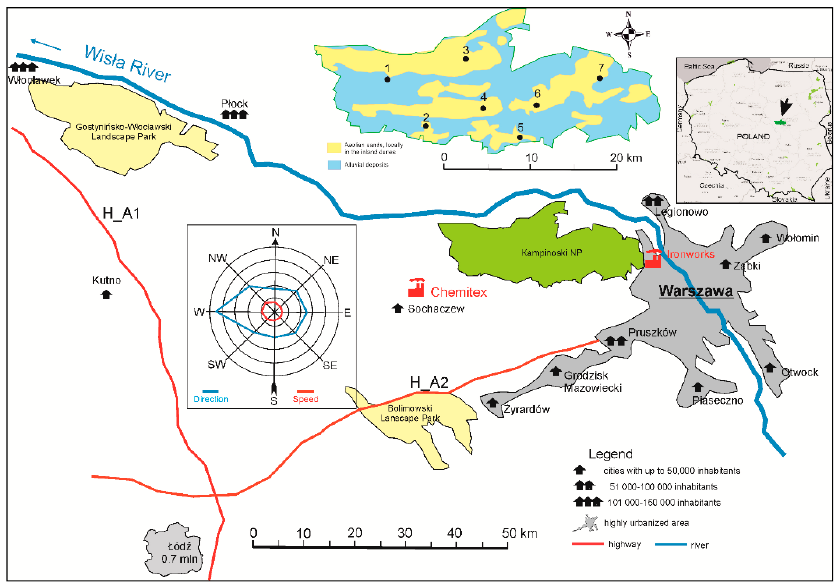
Figure 1. Location of Kampinoski National Park (KNP, area marked in green) in relation to the important spatial elements that may affect the park. In the upper right corner, the location of the KNP is marked against the background of the map of Poland. In the upper middle, a map of KNP is shown with the location of research plots (black spots) against the background of geological formations (yellow, aeolian sands; blue, alluvial deposits). Red icons on the main image indicate the most important possible sources of heavy metal emissions (chemical fiber plant in Chodaków on the left and smelter plant in Warsaw on the right).